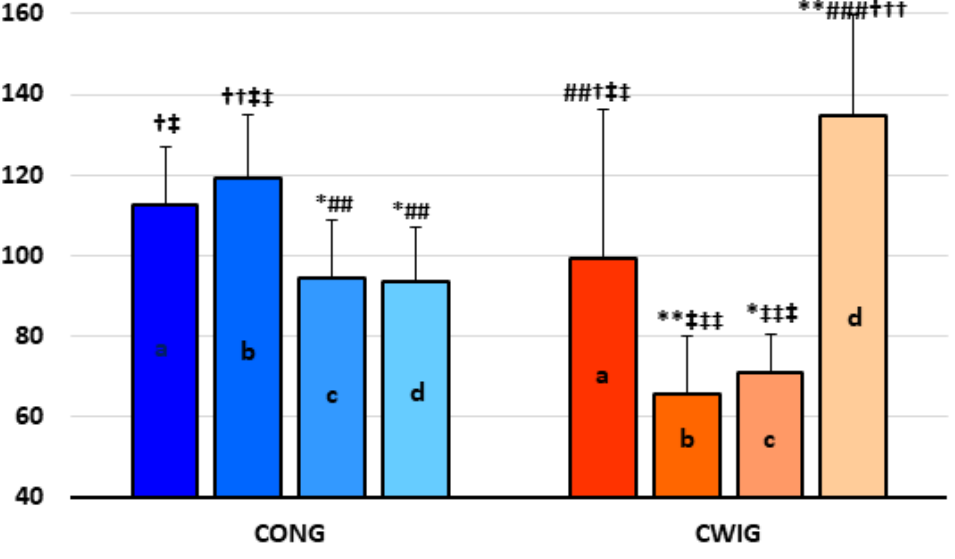
Figure 5. Change in GPX concentration after CWI. (Data are expressed as mean ± SD; A main effect was evident for time and group × time— p < 0.001; differences between each group were statistically significant— p < 0.05: difference from before, * p < 0.5, ** p < 0.5; difference from after game, ## p < 0.01, ### p < 0.001; di ff erence from before, † p < 0.05, †† p < 0.01; di ff erence from before, ‡ p < 0.05, ‡‡ p < 0.01, ‡‡‡ p < 0.001. CWI: cold-water immersion.).